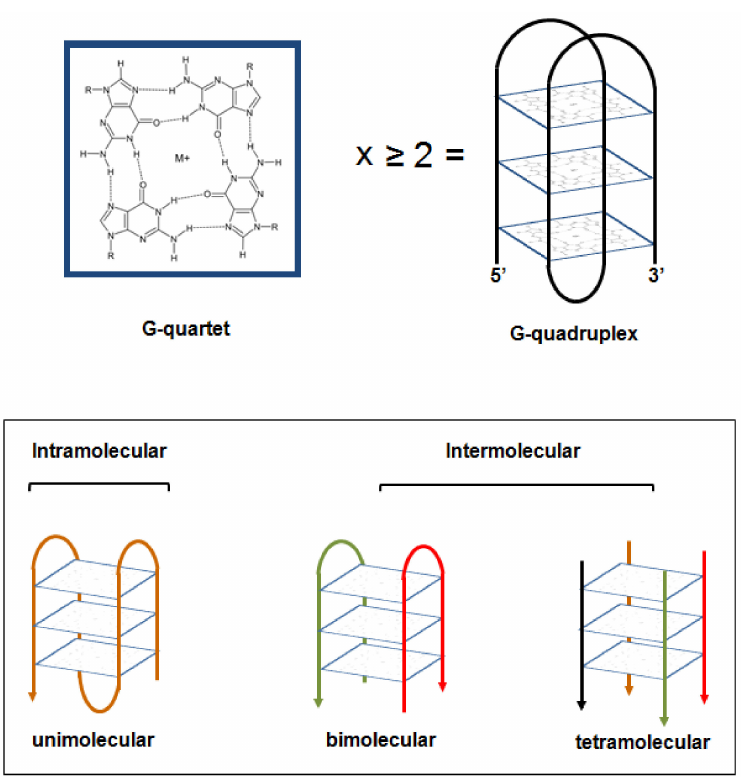
Figure 1. Schematic representation of a G-quartet arrangement and of a G4 structure. Examples of intramolecular and intermolecular G4 structures have been also depicted [2]. M+: monovalent